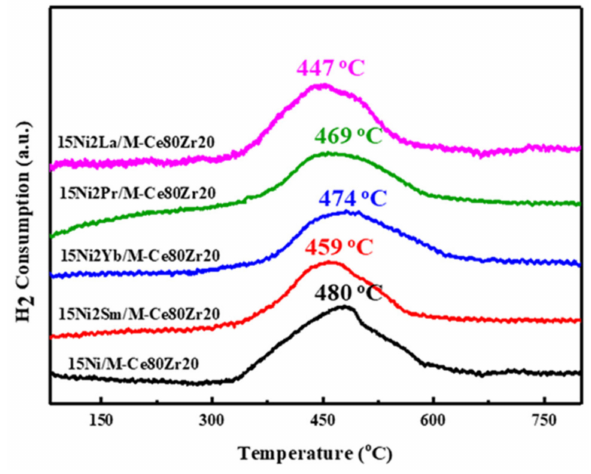
Figure 5. H 2 -TPR profiles of the 15Ni2R/M-Ce80Zr20 (R = La, Sm, Pr, Yb) catalysts.